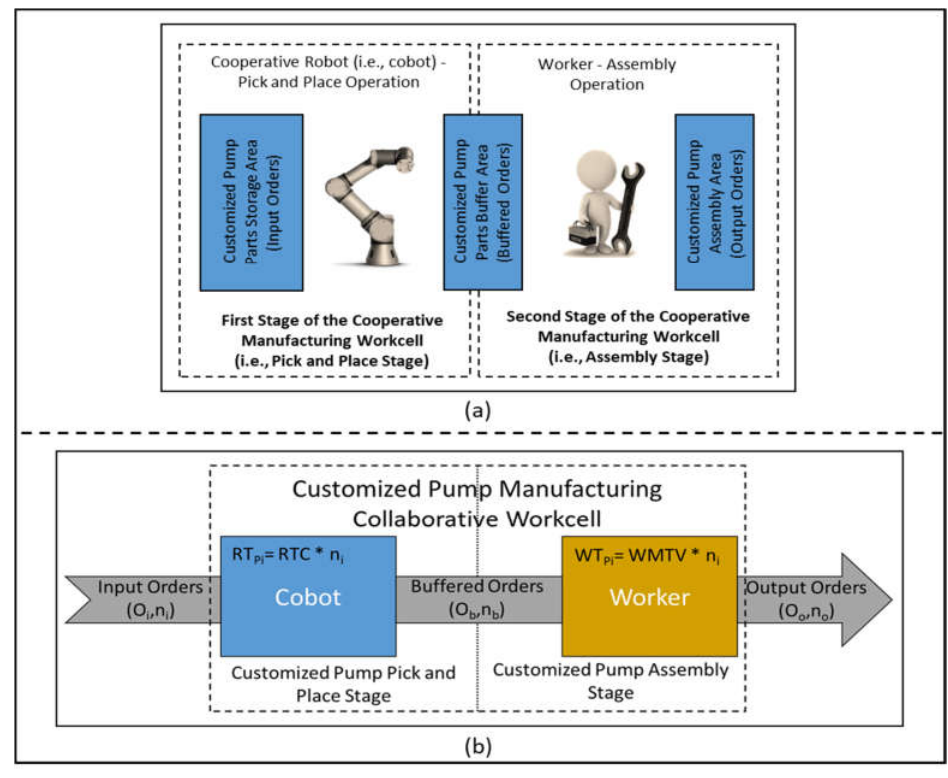
Figure 5. ( a ) Model of the case-study workcell; ( b ) Analysis of the case-study model. Table 2. Johnson Scheduling Based On RTC (Robot Time Constant) and WMTV (Worker Mean Time Value).